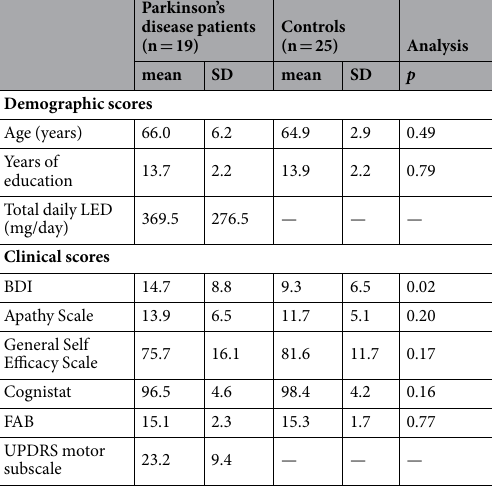
Table 1. Demographic and clinical variables. Statistics of demographic and clinical variables in PD and control groups are shown.